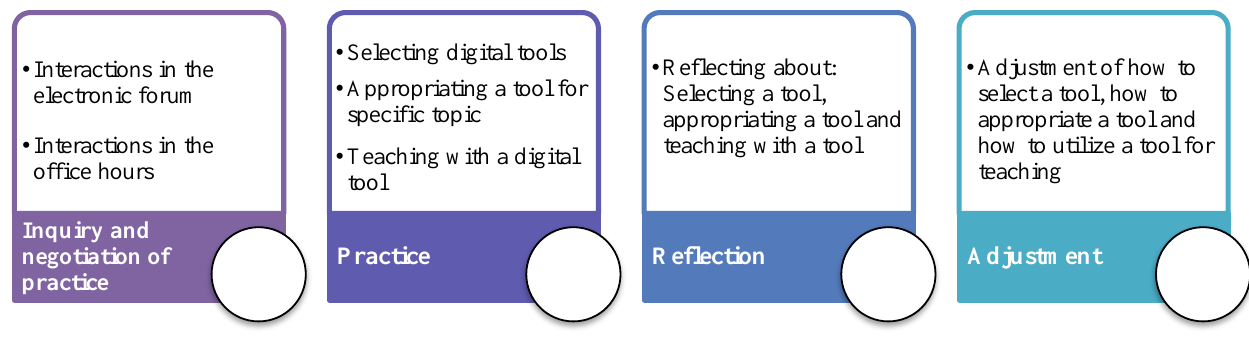
Figure 4. Teachers’ preparation model for adopting digital tools for